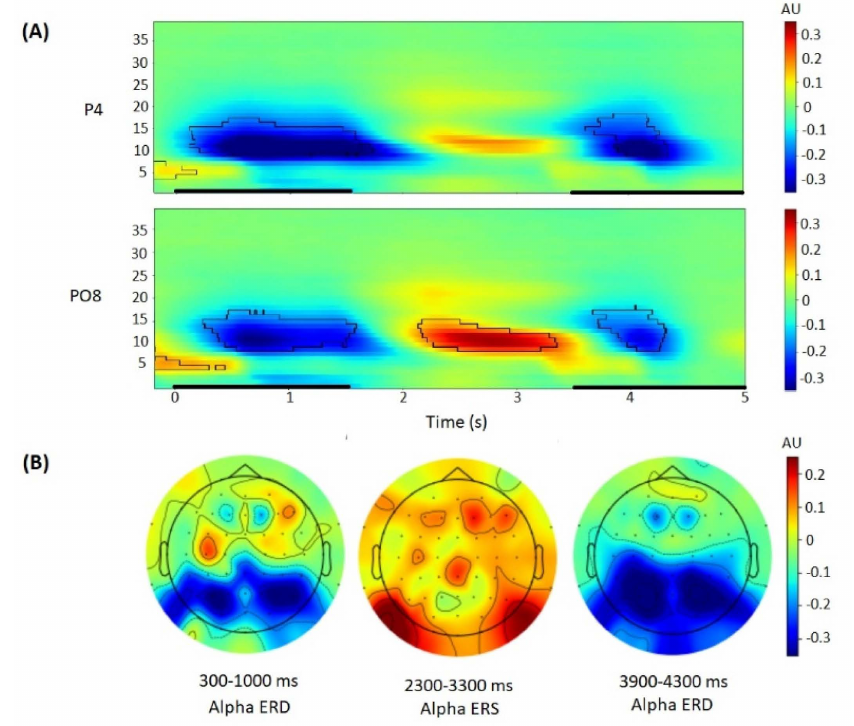
Figure 2. EEG oscillatory activity during Sternberg task trial performance. ( A ): Time-frequency plots of baseline-corrected oscillatory activity at the P4 ( top ) and PO8 ( bottom ) electrodes. Black outlines indicate p < 0.05 (permutation statistics). Time is shown relative to the stimulus onset. Black bold lines on x -axis indicate time periods of stimulus presentation for the encoding and probe stages. ( B ): Topographical maps of baseline-corrected alpha band activity at 300–1000 ms, 2300–3300 ms, 3900–4300 ms after stimulus